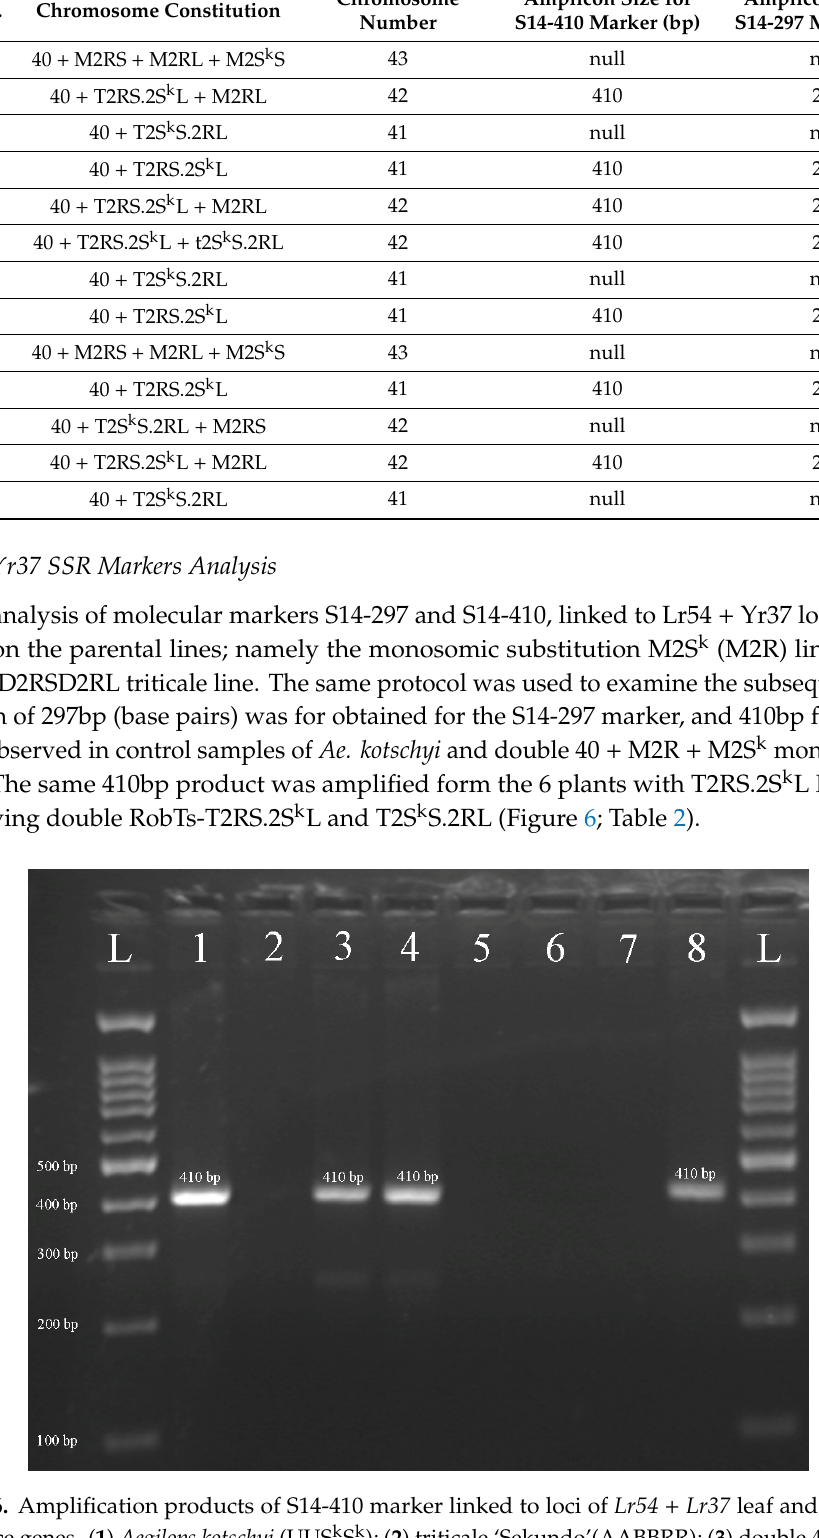
Table 2. Chromosome constitutions and Lr54 + Yr37 SSR marker analysis of triticale plants carrying divided 2S k chromosome.